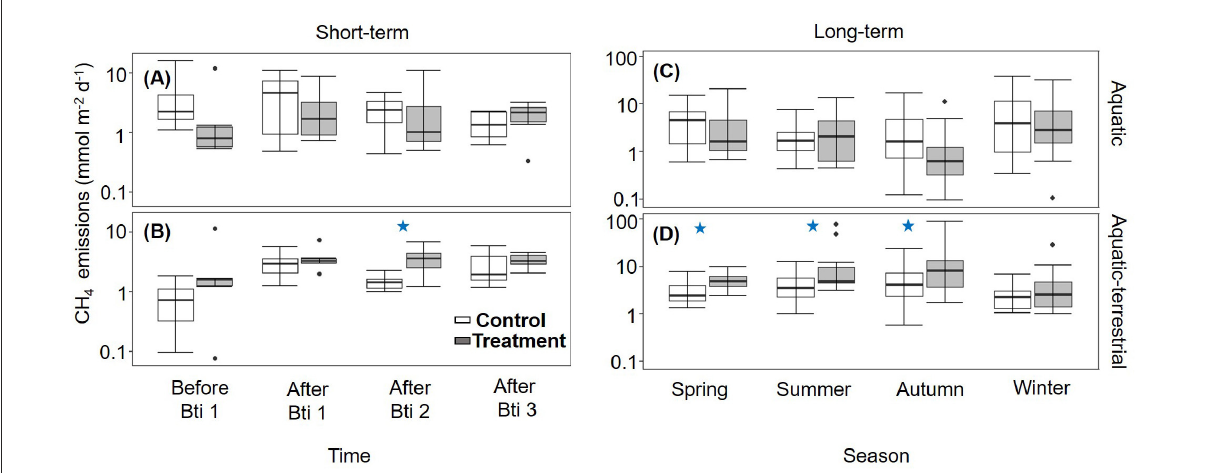
FIGURE1 Box plots for CH 4 emissions ( n = 6) measured in control (open boxes) and treated (filled boxes) FPMs. Data are presented for the short-term sampling during the Bti application period in the (A) aquatic and (B) aquatic-terrestrial compartments, and for the seasonal (long term) sampling in the (C) aquatic and (D) aquatic-terrestrial compartments. The lower and upper limits of the boxes show the 25th and 75th percentiles, respectively; the horizontal line inside the box is the median, and lower and upper whiskers show the 10th and 90th percentiles, respectively. Filled black circles are data falling outside the 10th and 90th percentiles. Blue stars denote significant difference between treated and control groups. Note that the y -axes are log-scaled.